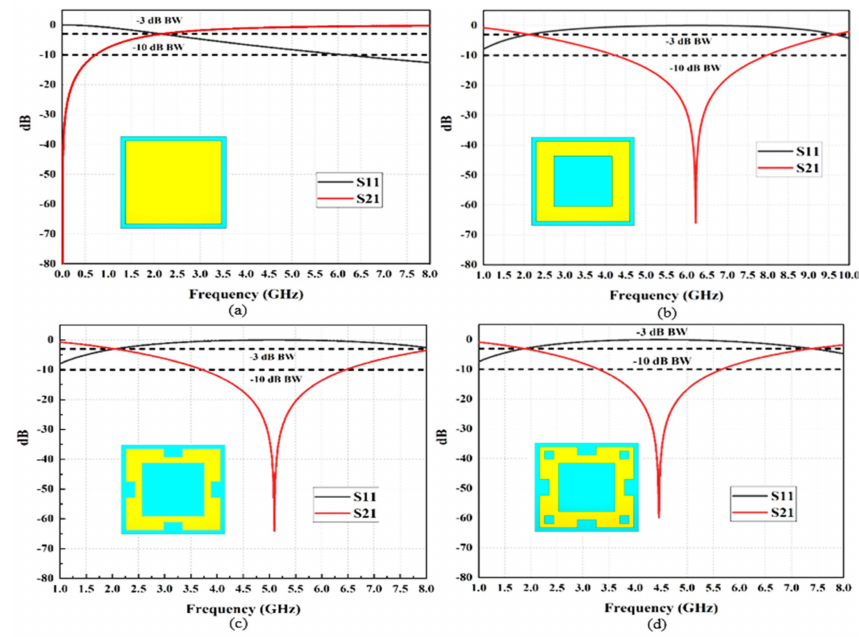
Figure 5. Simulated results of the S11 and S21 of the proposed FSS unit cells: ( a ) square metallic patch, ( b ) square ring, ( c ) square ring with edge rectangular slot, and ( d ) slotted square